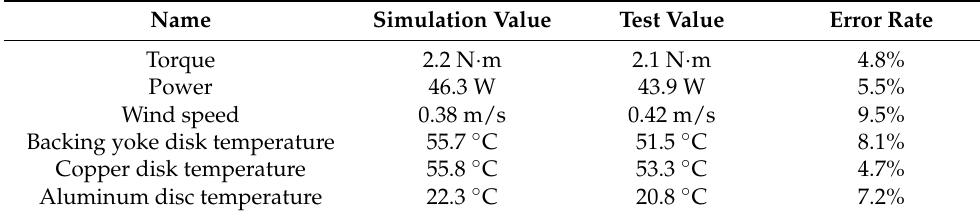
Table 2. Comparison of test and simulation results (200 r/min and 4 mm).